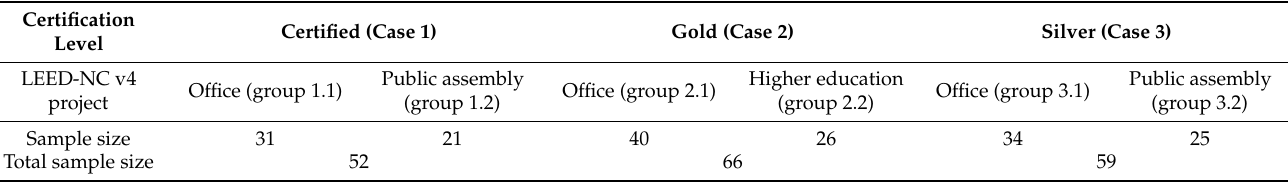
Table 2. Corrected sample sizes of US-LEED v4